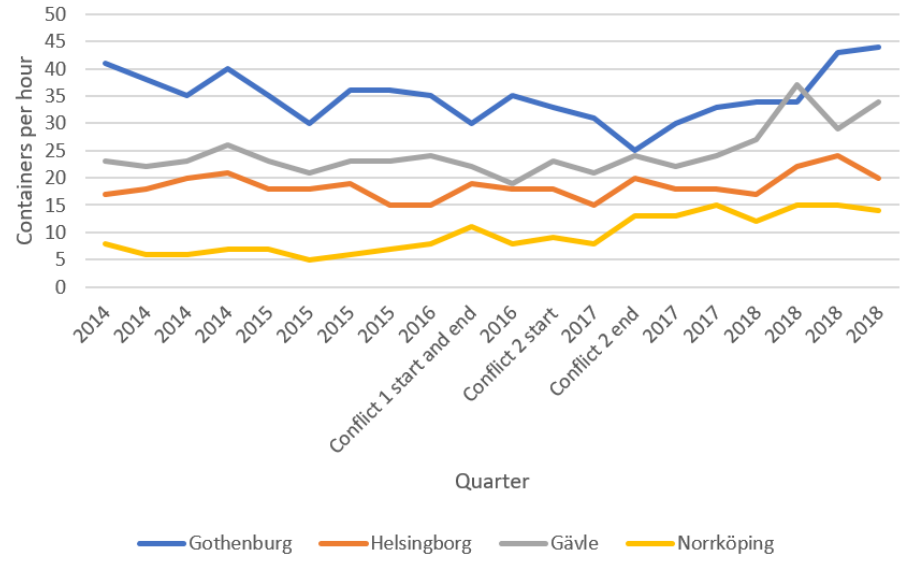
Figure 10. Containers lifts per hour at the four ports.